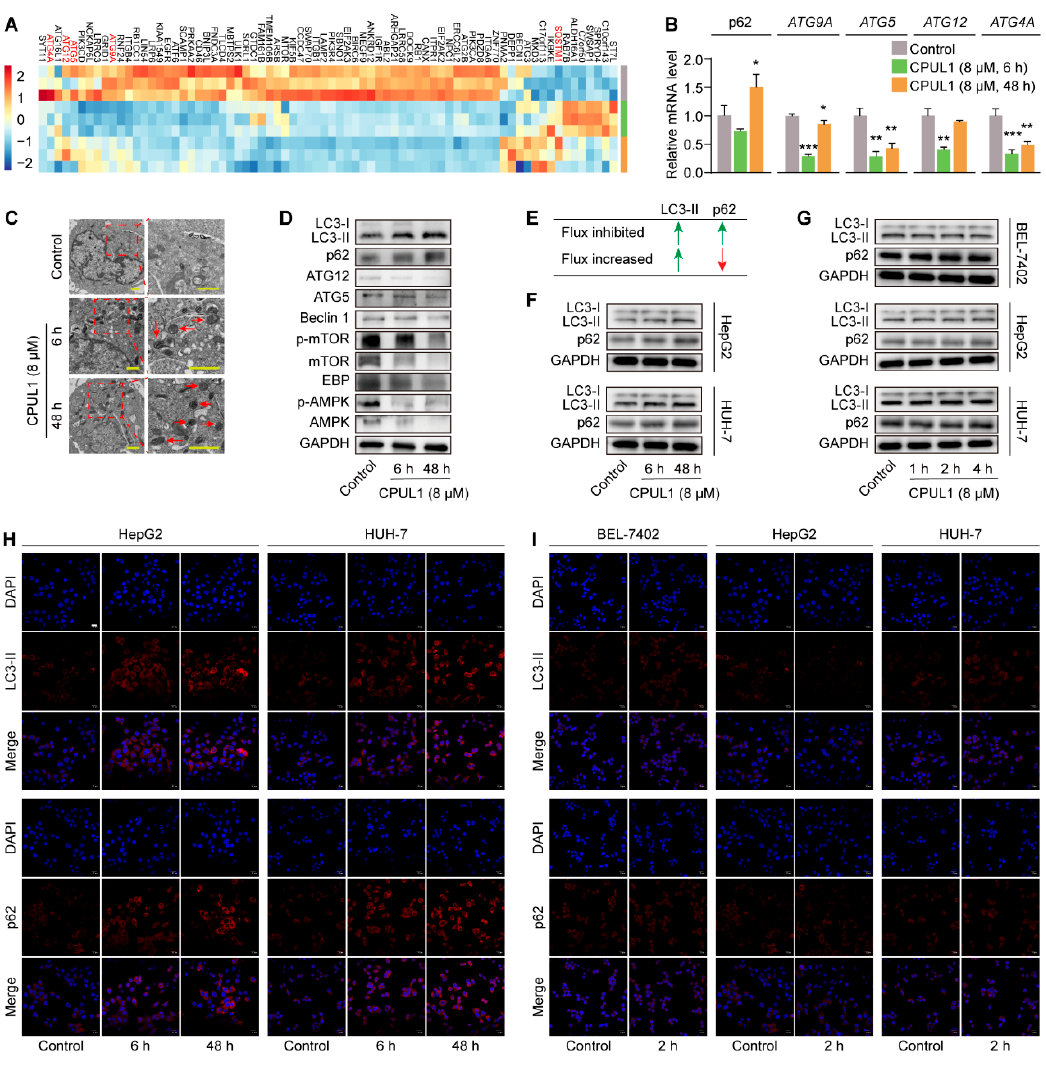
Figure 8. Effects of CPUL1 on autophagy pathway. ( A ) The cluster heatmap of autophagy-related genes was identified for CPUL1 treatments and the control, and the blue to the red color scale indicate the value of the differentially expressed gene (DEG) expression. ( B ) QPCR analysis of p62, ATG9A, ATG5, ATG12, and ATG4A in the control and CPUL1-treated BEL-7402 cells. Cells were treated with CPUL1 (8 µ M) for 6 h and 48 h. ( C ) The cells were treated with or without CPUL1 (8 µ M) for 6 h and 48 h. Autophagosomes were observed by TEM. Scale bar = 1 µ m. ( D ) Western blot analysis of LC3, p62, ATG12, ATG5, Beclin1, mTOR, p-mTOR, EBP, AMPK, and p-AMPK in the control and CPUL1-treated BEL-7402 cells. Cells were treated with CPUL1 (8 μ M) for 6 h and 48 h. ( E ) Schematic representation of the LC3-II and p62 levels under increased or inhibited autophagy flux. Green arrow indicated increase and red arrow indicated decrease. ( F ) HepG2 and HUH-7 cells were treated with 8 μ M CPUL1 for 6 h or 48 h, and the levels of LC3- II/ I and p62 were assessed by western blotting. ( G ) BEL-7402, HepG2, and HUH-7 cells were treated with 8 μ M CPUL1 for 1 h, 2 h, and 4 h, respectively, and the level of LC3- II/ I and p62 were analyzed by Western blotting. ( H ) HepG2 and HUH-7 cells were treated with 8 μ M CPUL1 for 6 h and 48 h, and immunostained with p62 and LC3 antibodies. DAPI (blue) was used to stain the nuclei, and the fluorescent images were observed with a confocal laser scanning microscope (Olympus FV3000). Scale bar = 20 μ m. ( I ) BEL- 7402, HepG2, and HUH-7 cells were treated with 8 μ M CPUL1 for 2 h, and immunofluorescence labeling with p62 and LC3 antibodies was performed. DAPI (blue) was used to stain the nuclei, and the fluorescent images were observed with confocal laser scanning microscopy (Olympus FV3000). Scale bar = 20 μ m. The data were expressed as the mean ± SD; * p < 0.05, ** p < 0.01, *** p < 0.001. ns, not significant.